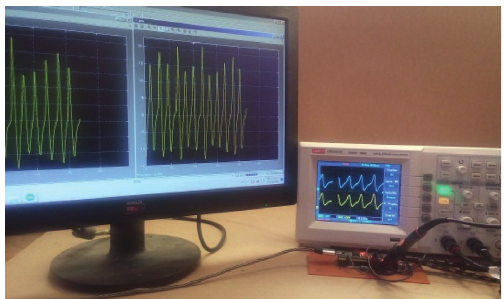
Figure 7: Data visualization on the computer screen.